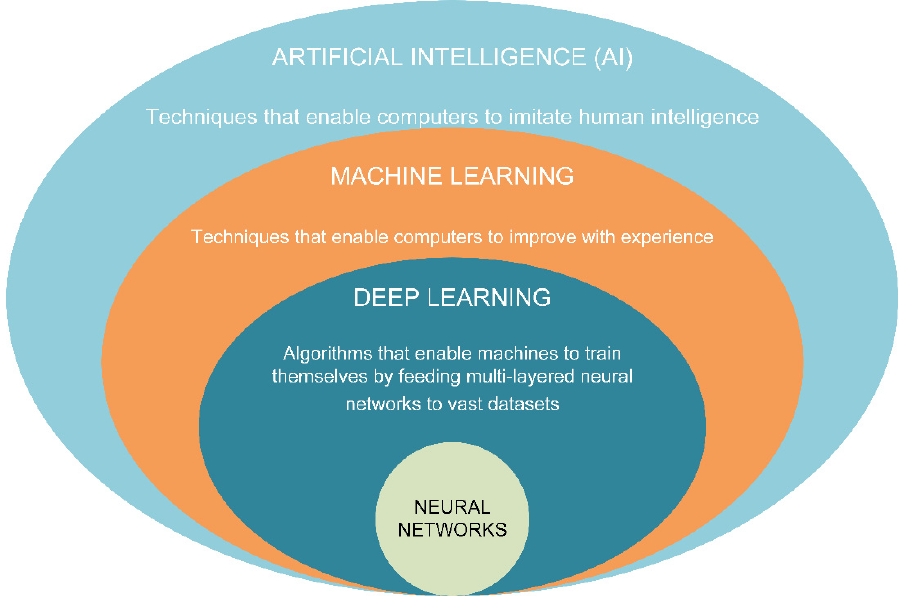
Figure 5. Artificial intelligence divisions illustration.